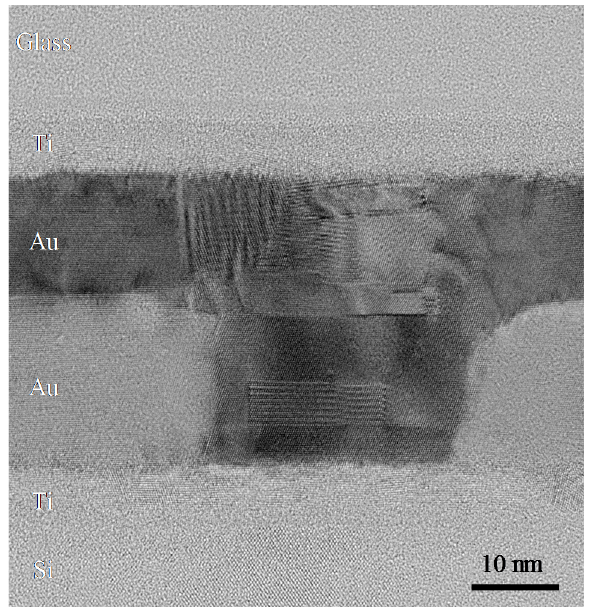
Figure 15. Transmission electron microscope (TEM) image of the bonded sample with a 15-nm-thick Au film.